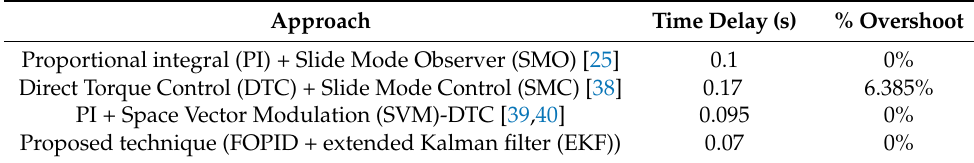
Table 5. Comparison with existing techniques with no